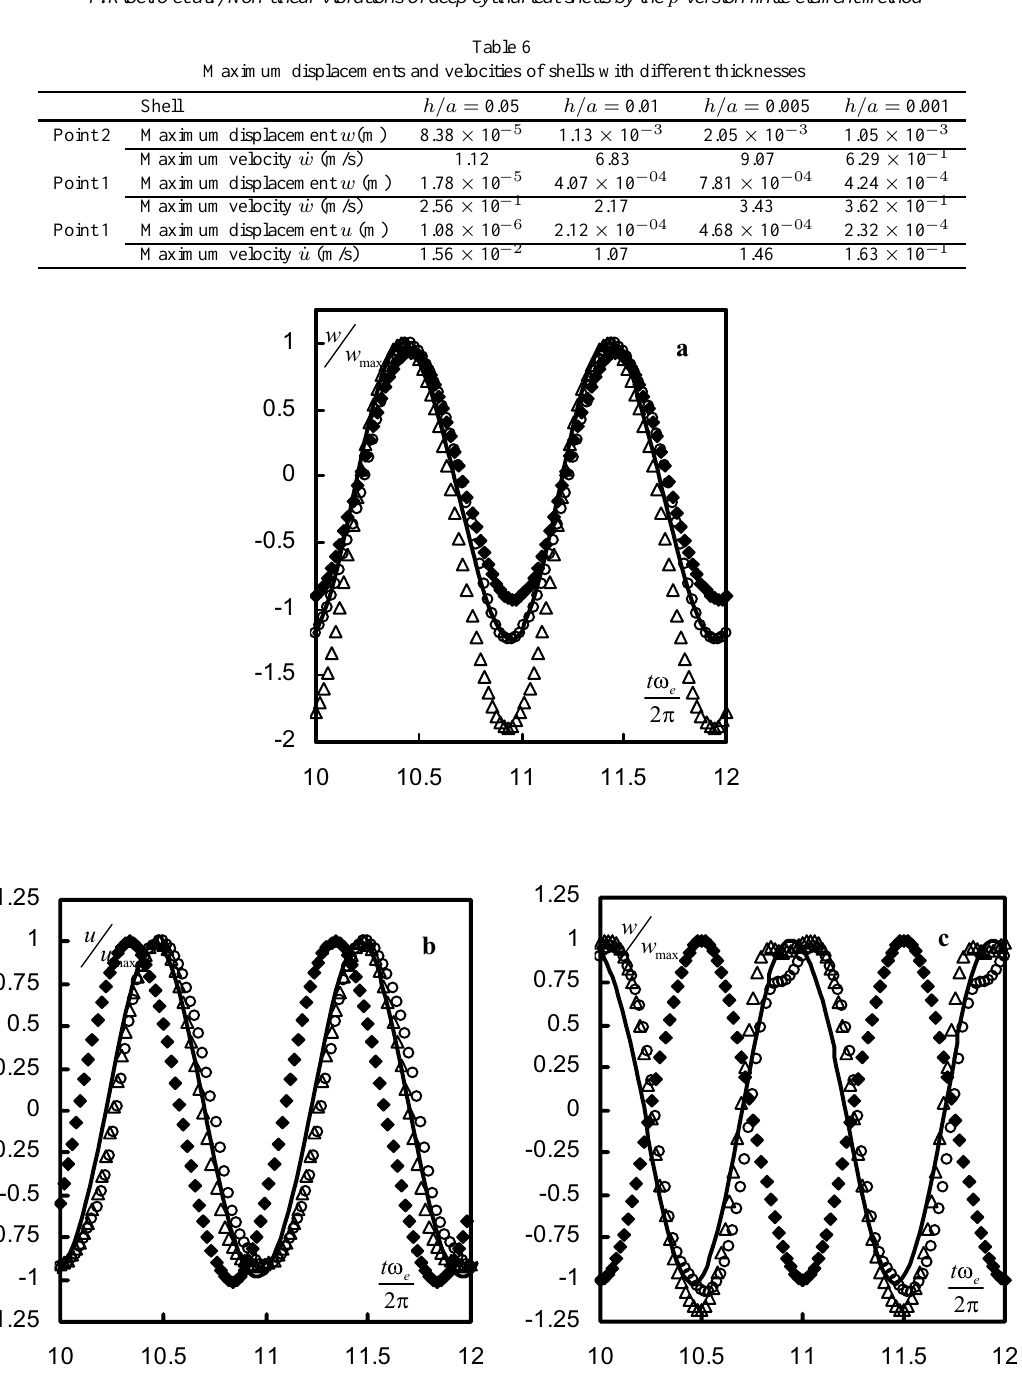
Fig. 8. Time plots of oscillations of Shells (cid:2) h/a = 0.05, — h/a = 0.01, ∆ /a = 0.005, o h/a = 0.001, at the following points and directions: (a) Point 2, direction z ; (b) Point 1, direction x ; (c) Point 1, direction z . were considered. In these numerical tests, the radius of all shells are equal to the projected length, i.e. R = a , and the thicknesses are: h/a = 0.05, h/a = 0.01, h/a = 0.005 and h/a = 0.001. The excitation force has similar characteristics to the one of the previous examples, except in what the amplitude is concerned. In the case of